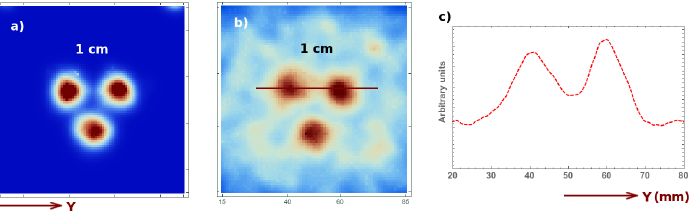
Figure 8. Image reconstruction of a 4 s acquisition of a 1 cm Derenzo at 5 cm from the collimator without background ( a ), with background ( b ) (8:1 signal to background ratio) and its profile ( c ) (see reference system defined in Figure